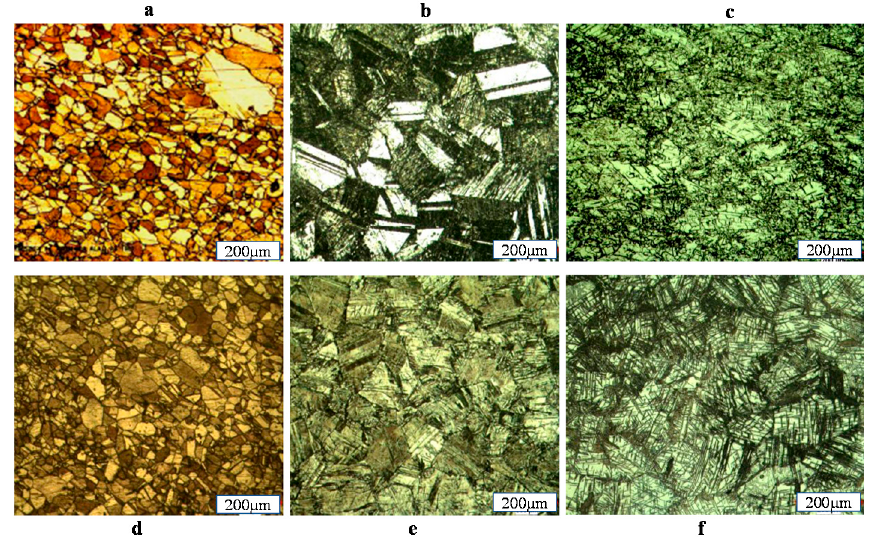
Figure 2. Metallographic images: ( a , d ) after industrial deformation without DP718; ( b , e ) after thermal treatment DP718 before DP718 deformation; ( c , f ): after DP718 deformation. ( a – c ) correspond to Sample A. ( d – f ) correspond to Sample B.